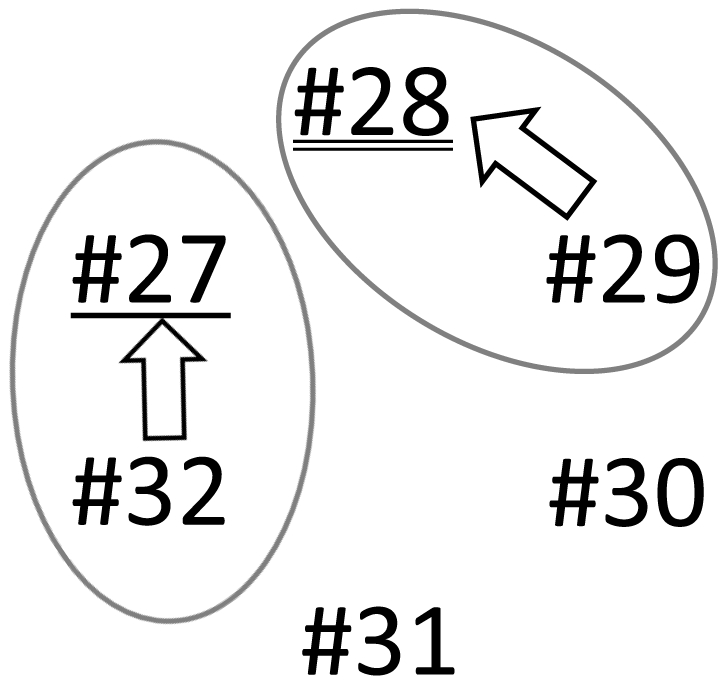
Social relationships among the 6 porpoises as revealed by this study.The underlined number indicates an immature female, and the double underlined number indicates a juvenile male. The others are adult males. The tips of the arrows indicate the initiators, and the bases of the arrows indicate the followers.